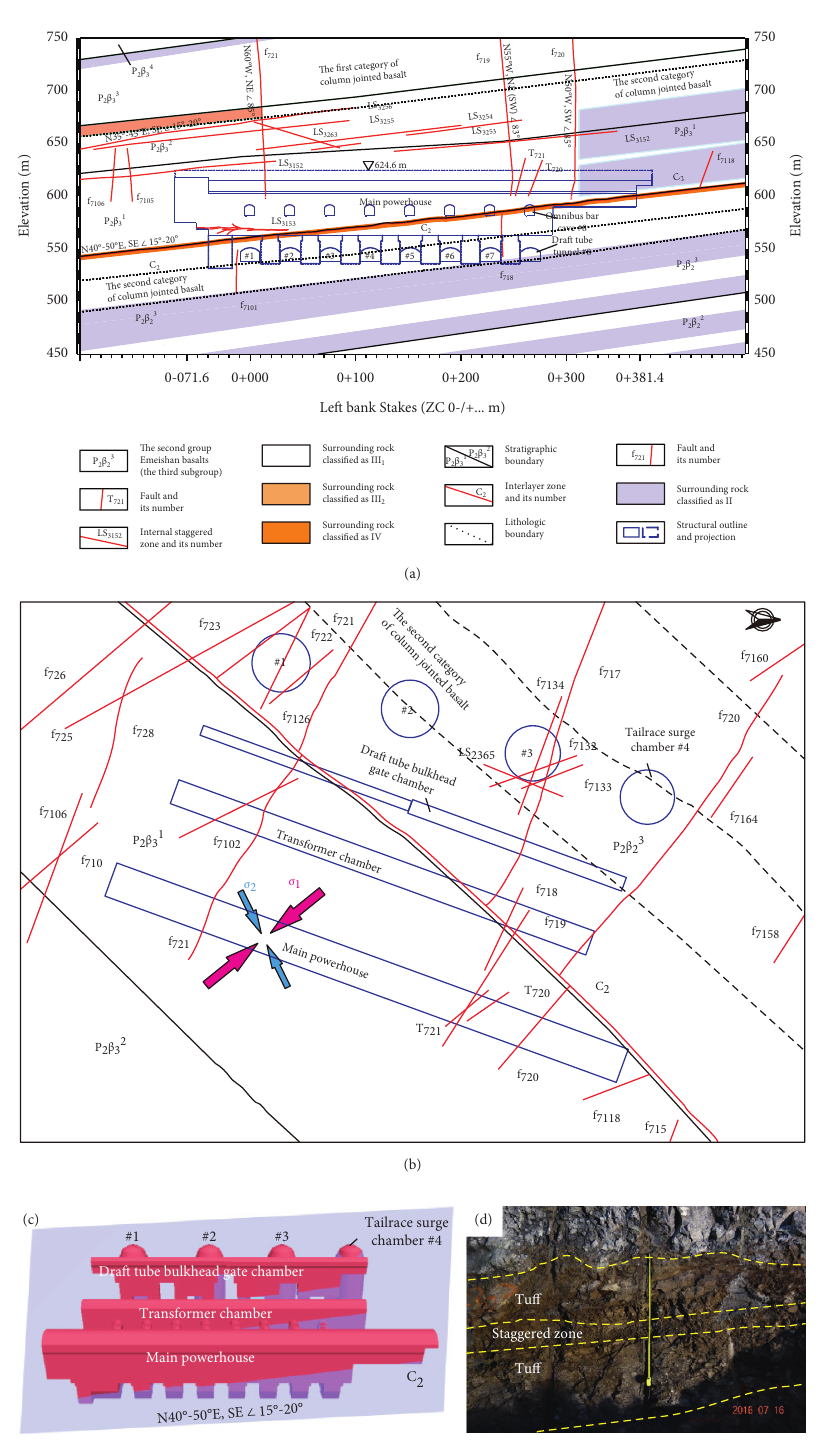
Figure 2: Geological conditions of the Baihetan left bank underground powerhouse: (a) a geological cross section of the left bank main powerhouse along the downstream sidewall; (b) a geological cross section of the main power house on the left bank along the 602m elevation; (c) a spatial layout diagram of the interlayer shear zone C 2 ; (d) typical characteristics of C 2